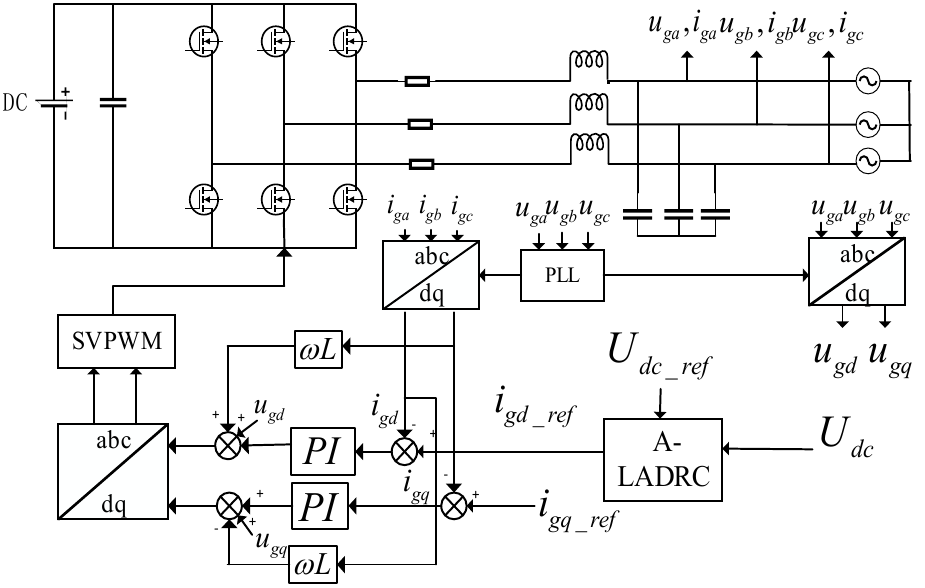
Figure 2. Structure diagram of inverter control scheme. The main function of A–LADRC is to obtain the current reference value on axis d by adjusting the error signal between the measured DC bus voltage and the reference signal. PI control is adopted in the inner loop control strategy, and the output of LADRC is taken as the reference to compare with the measured current component. Inputs the modulation signal are then obtained through coordinate inverse transformation into space vector pulse width modulation in order to obtain the driving signal to control the turn-on and turn-off time of MOSFET and complete the control of DC bus voltage [28,29]. LADRC is composed of a linear extended observer (LESO), tracking differentiator (TD), and linear error state feedback control law (LESF) [30,31]. The structure of the controller is shown in Figure